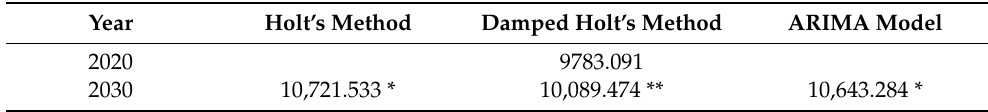
Table 4. Predicted population by different machine learning methods.